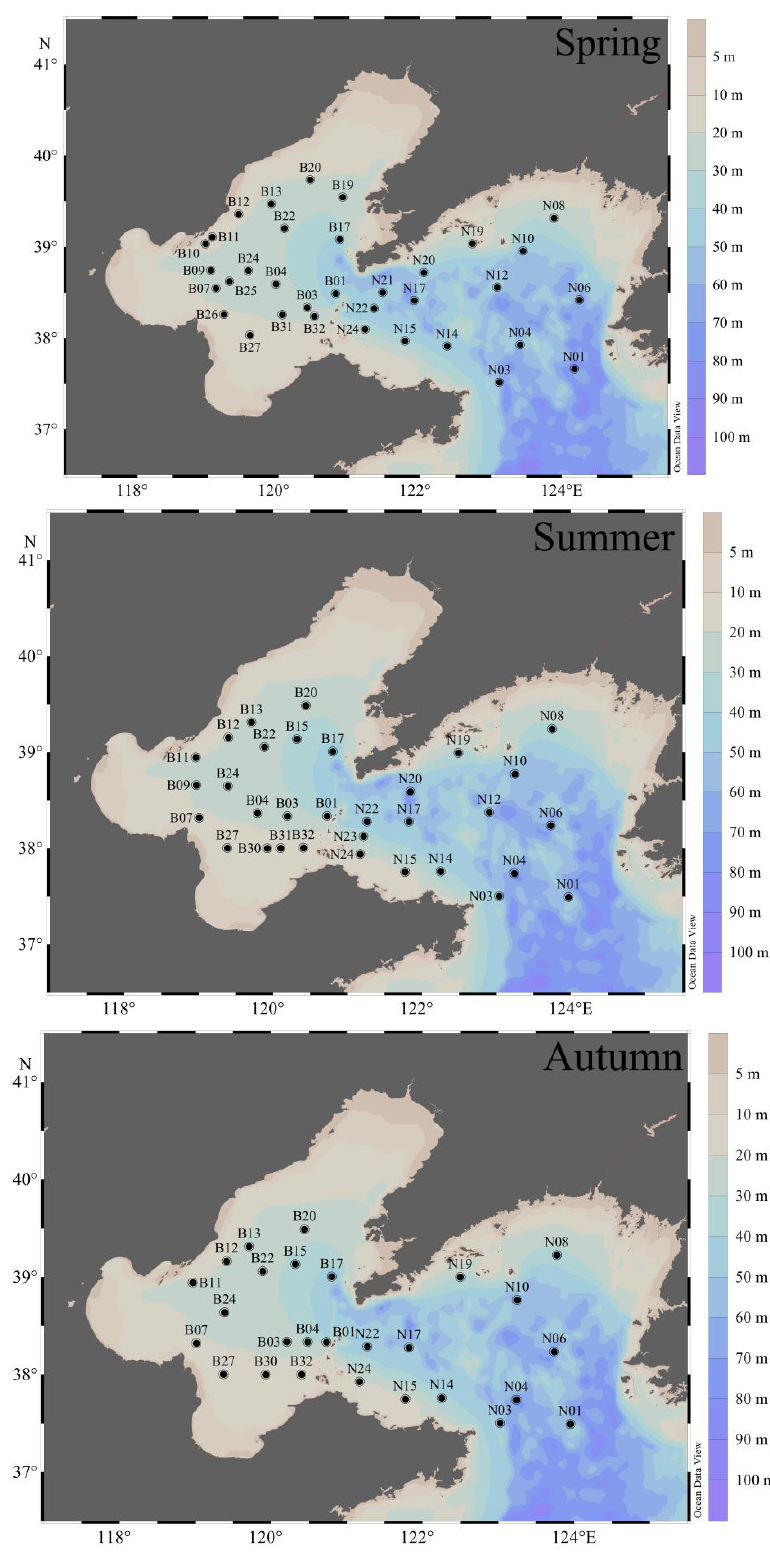
Figure 1. Location of sampling stations (black dots) during three cruises in the BS and NYS. The name of the stations is defined as “Bn” at BS and “Nn” at NYS and the color bar is bathymetry.